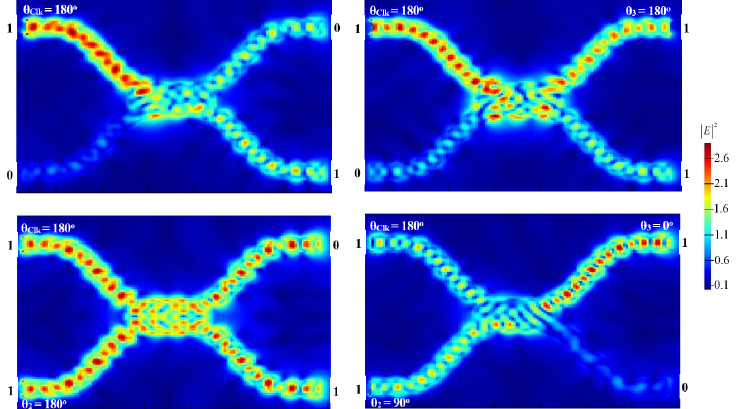
Figure 13. Light field distributions for NAND function utilizing 2 × 2 silicon waveguide at 1.55 μ m.